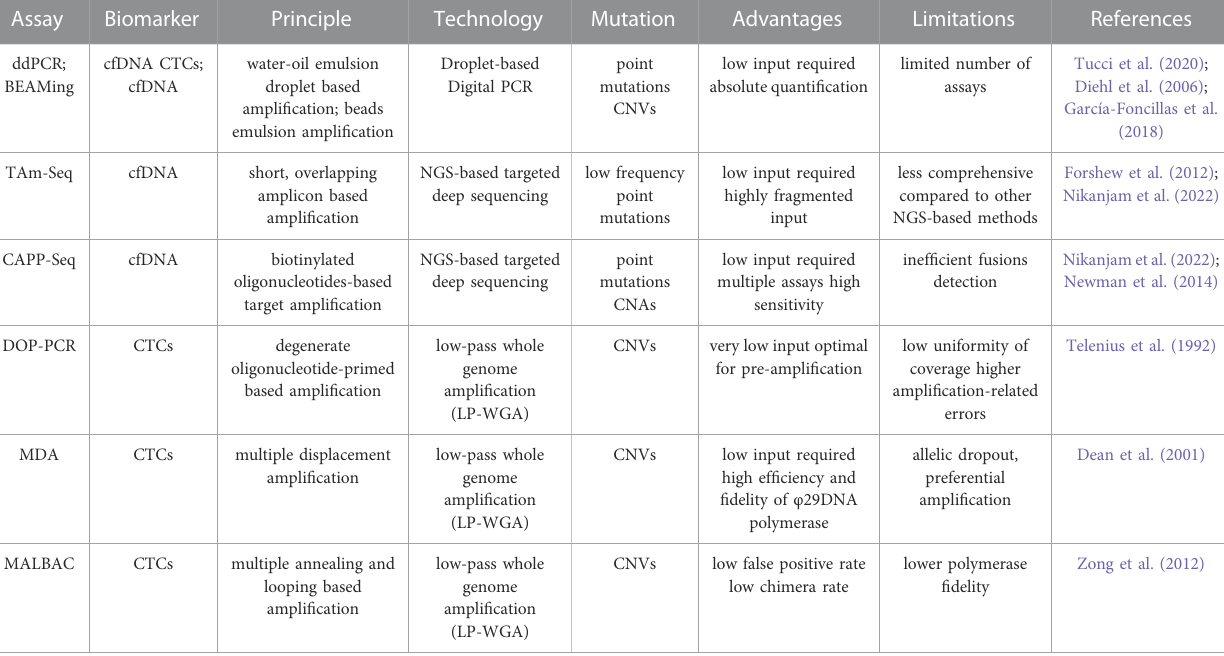
TABLE 2 Overview of techniques for point mutations and CNVs detection in liquid biopsy.